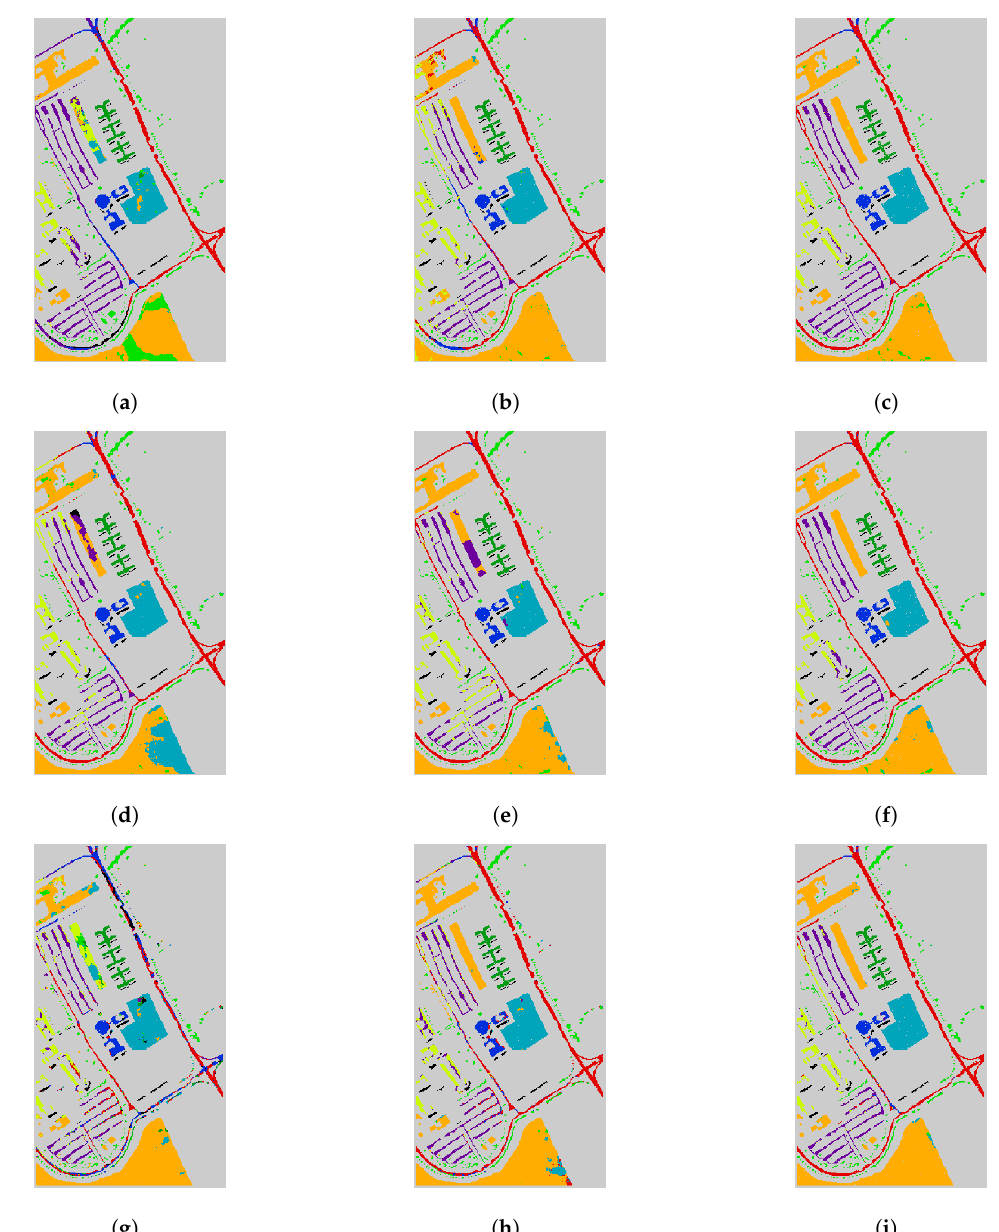
Figure 5. Sample results from experiment one, Pavia University dataset. The scheme is identical to the Figure 4. ( a ) 5 s/A9 OA 79.7% AA 88.4% κ 0.75; ( b ) 15 s/A9 OA 91.3.3% AA 93.8% κ 0.89; ( c ) 50 s/A9 OA 97.8% AA 98.2% κ 0.97; ( d ) 5 s/A3 OA 81.7% AA 91.0% κ 0.77; ( e ) 15 s/A3 OA 92.3% AA 94.7% κ 0.90; ( f ) 50 s/A3 OA 97.4% AA 97.3% κ 0.97; ( g ) 5 s/A5 OA 77.1% AA 79.8% κ 0.71; ( h ) 15 s/A5 OA 90.4% AA 88.6% κ 0.88; ( i ) 50 s/A5 OA 96.6% AA 96.4% κ